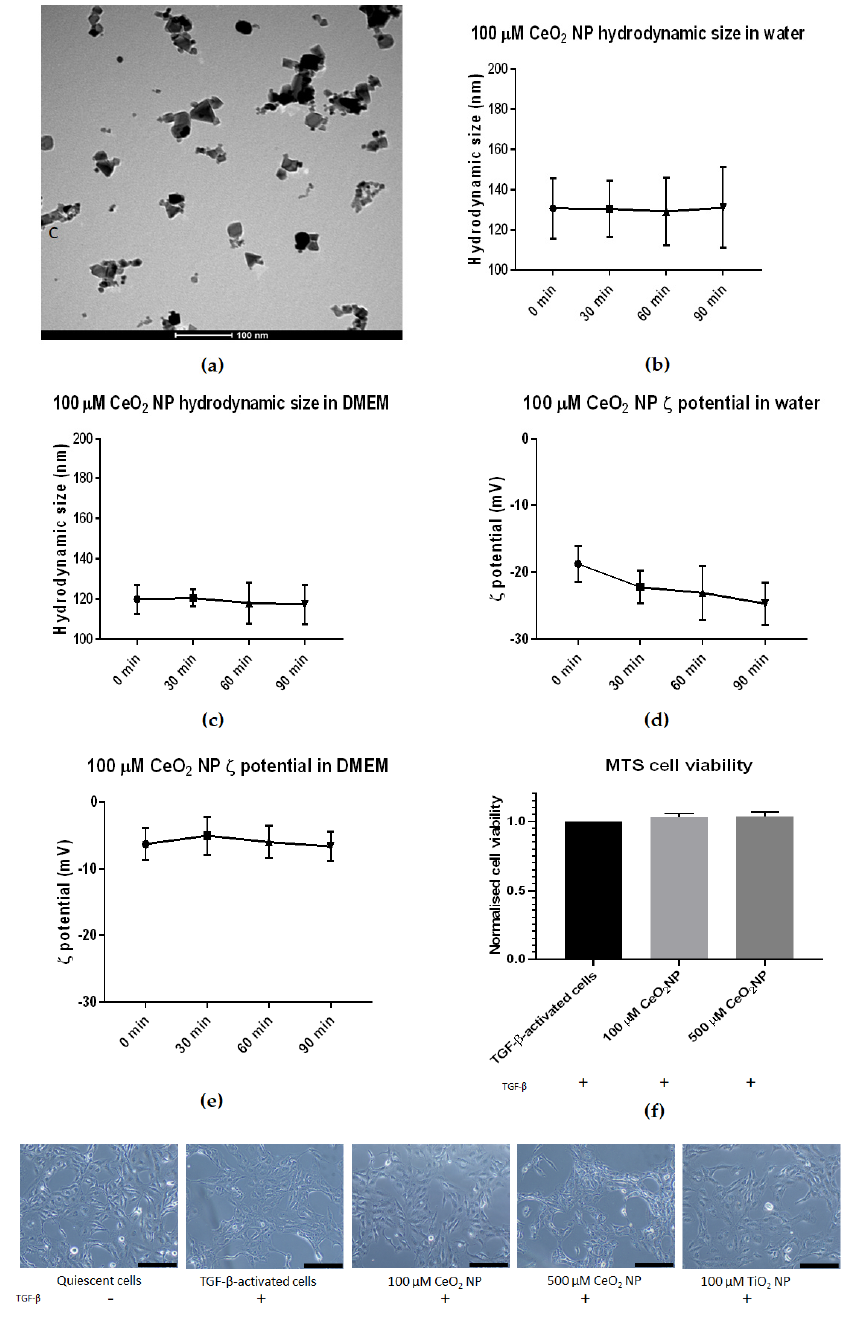
Figure 1. Characterisation of CeO 2 NP used in this study. ( a ) TEM analysis revealed CeO 2 NP to be cubic-shaped and approximately 25 nm in diameter. ( b ) DLS analysis revealed CeO 2 NP hydrodynamic size in water to be stable over 90 min at approximately 130 nm ( n = 3). ( c ) CeO 2 NP hydrodynamic size in 1% DMEM showed a slightly smaller size at approximately 120 nm and was also stable over 90 min ( n = 3). ( d ) CeO 2 NP in water showed a downward trend in ζ potential ( n = 3). ( e ) CeO 2 NP ζ potential in 1% DMEM showed more stable ζ potential ( n = 3). ( f ) 100 µ M and 500 µ M CeO 2 NP showed similar cell viability as TGF- β -treated control cells when measured using MTS assay ( n = 3). ( g ) Light microscope images taken at 10 × magnification of quiescent cells, TGF- β -activated cells, 100 µ M CeO 2 NP, 500 µ M CeO 2 NP and TiO 2 NP-treated cells ( n = 3). Scale bar represents 200 µ m. Error bars represent standard error of the mean (SEM); one-way analysis of variance (ANOVA) was used to calculate